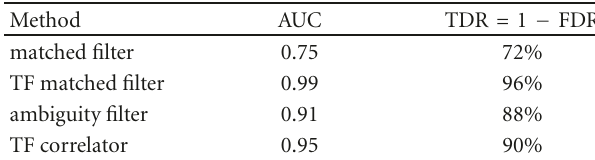
Figure 4: Simulated signal, with high-energy harmonics: (a) SNR of 20dB, and (b) SNR of 0dB. Noise is coloured Gaussian noise. Table 2: Seizure detection results using newborn